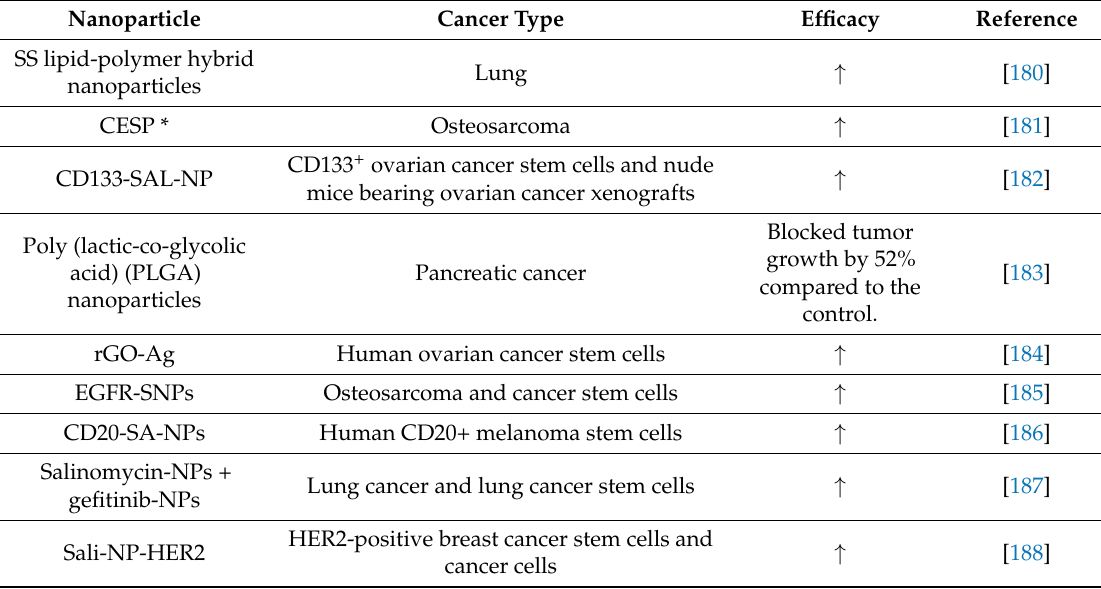
Table 3. Delivery of Salinomycin using